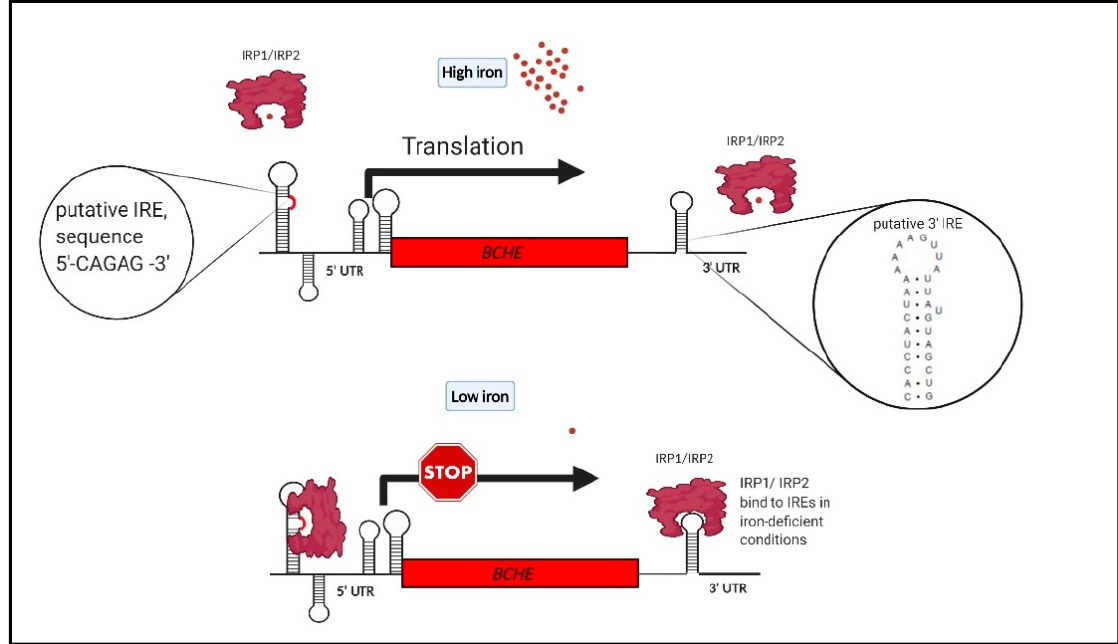
Figure 2. Proposed model of BChE expression regulation by iron in the activated glial cells. mRNA sequence